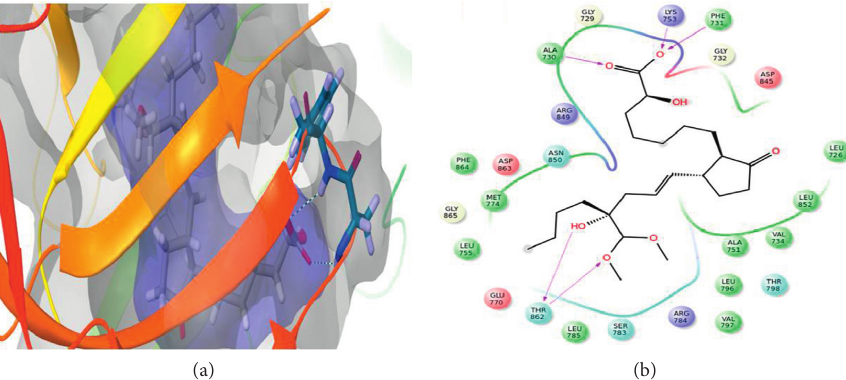
Figure 4: Docking complex of HER2 with compound 2 generated using Glide XP module of Schr¨odinger suite is shown in this figure. The proteins, ligand, and binding pockets are represented in ((a) 3D graphics) ribbon, sticks, and surface models, respectively. The residues of the HER2 that are within 4 ˚A proximities to compound 2 are illustrated in (b) 2D graphics. Dotted lines denote “hydrogen bonds” between the corresponding atoms.